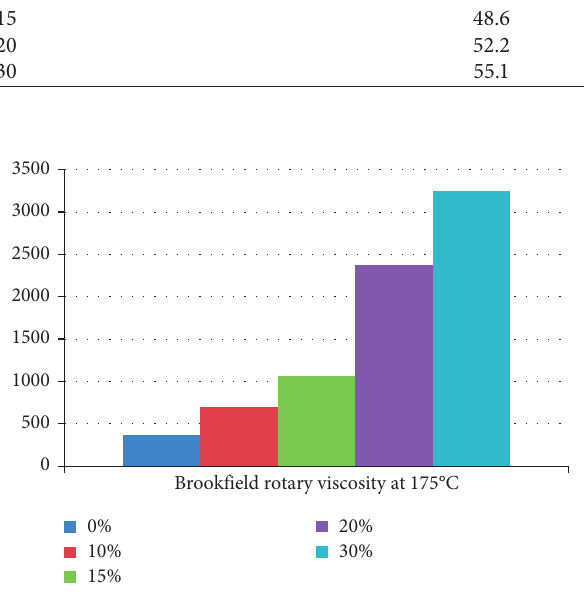
Figure 1: Brookfield rotary viscosity of crumb rubber-modified asphalt (MPa · s).